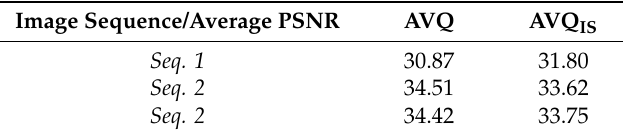
Table 3. Average PSNR–Dataset 1.